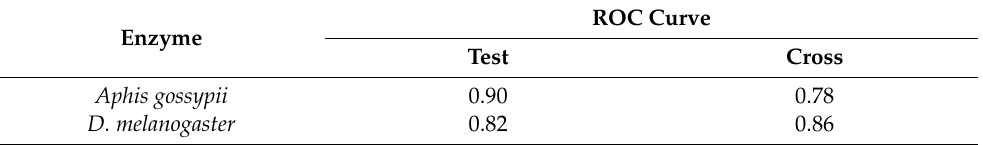
Table 3. Values for the ROC curves, during the test and cross-validation, for each RF model. ROC Curve Enzyme Test Cross Aphis gossypii